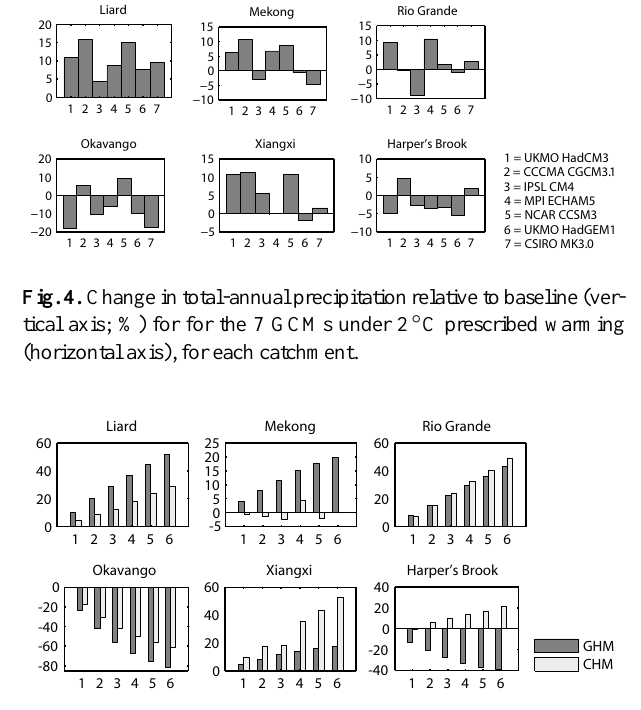
Fig. 5. Change in mean annual runoff relative to baseline (verti- cal axis; %) for the 6 prescribed warming temperatures (horizontal axis), as simulated by the GHM and CHM respectively, for each catchment.